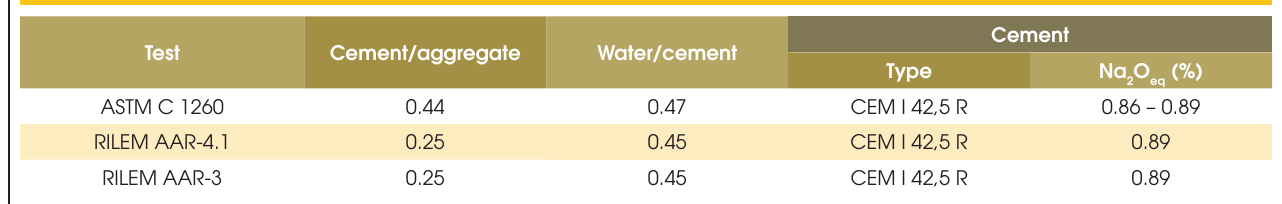
Table 1 – Characteristics of the mixes used in accelerated expansion